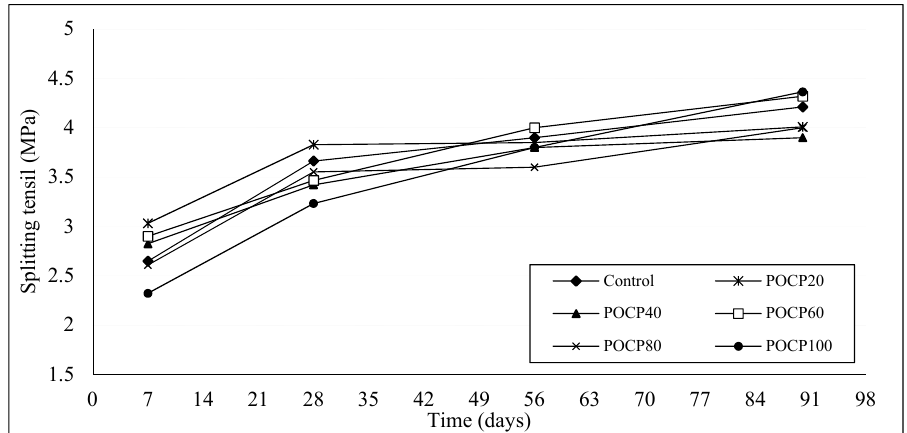
Figure 16. Splitting tensile failure.